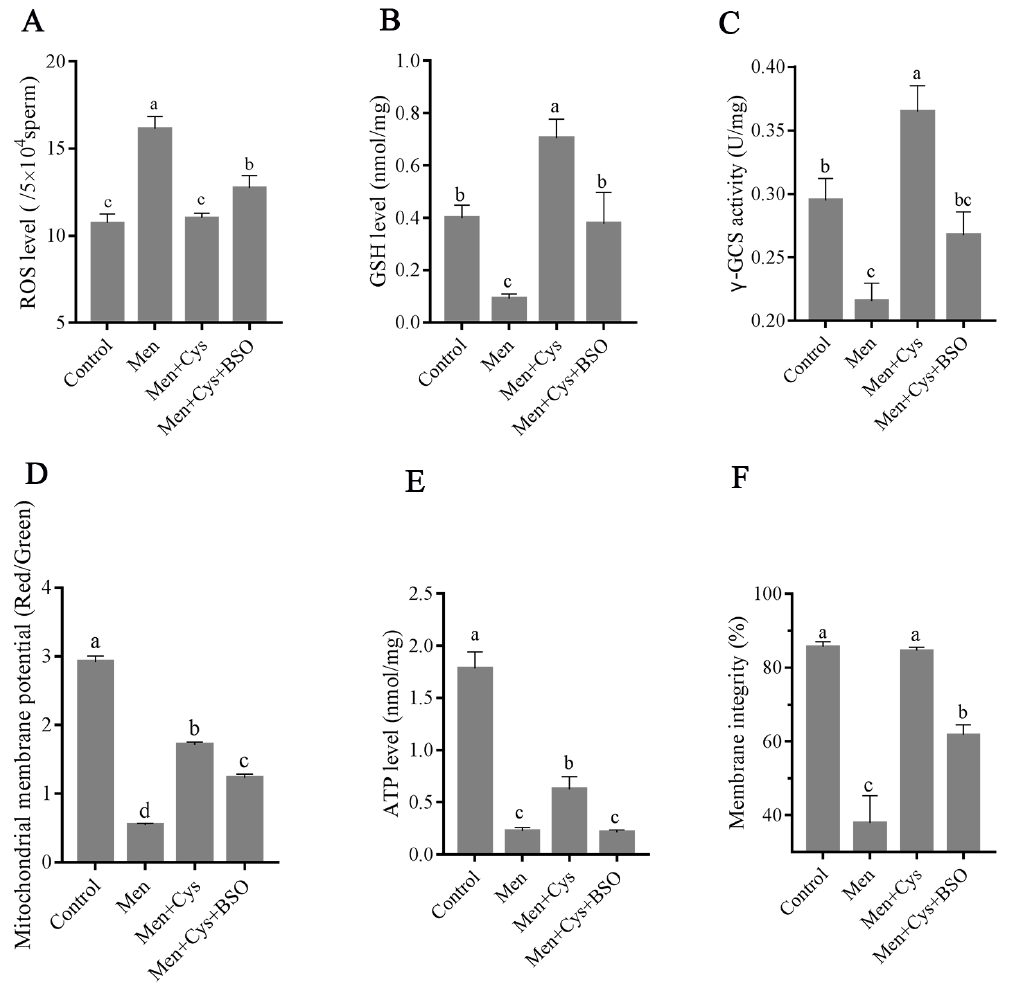
Figure 6. Effect of cysteine on the GSH level and the ROS damage induced by menadione in vitro condition. ROS level (A), GSH level (B), γ-GCS ac - tivity (C), mitochondrial membrane potential (D), ATP level (E) and membrane integrity (F). Data are the mean±standard deviation (SD). Cys, cysteine; Men, menadione; BSO, buthionine sulfoximine; γ-GCS, γ-glutamylcysteine synthetase. a-c Columns with different lowercase letters differ significantly (p<0.05).